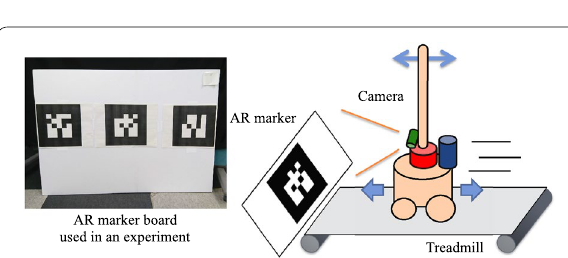
Fig. 4 AR markers usage in the experimental condition. An (right), and AR marker board used in this experiment (left)